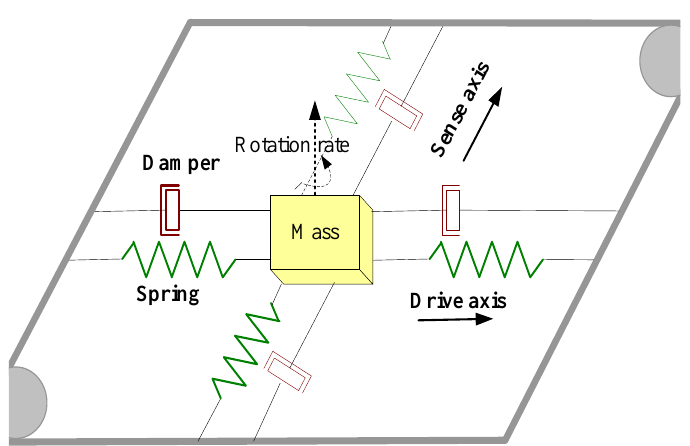
Rotation axisSpringDamper Mass Drive